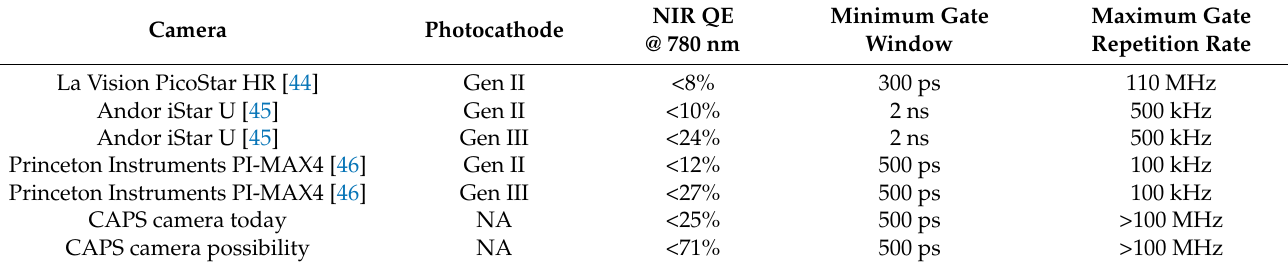
Table 3. CAPS proof-of-concept camera compared to commercially available Intensified CCD